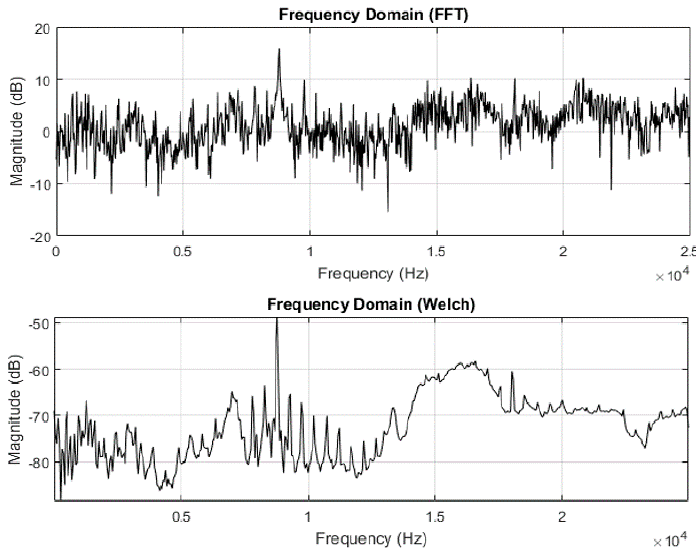
Figure 3. Frequency domain analysis using FFT and Welch estimate.